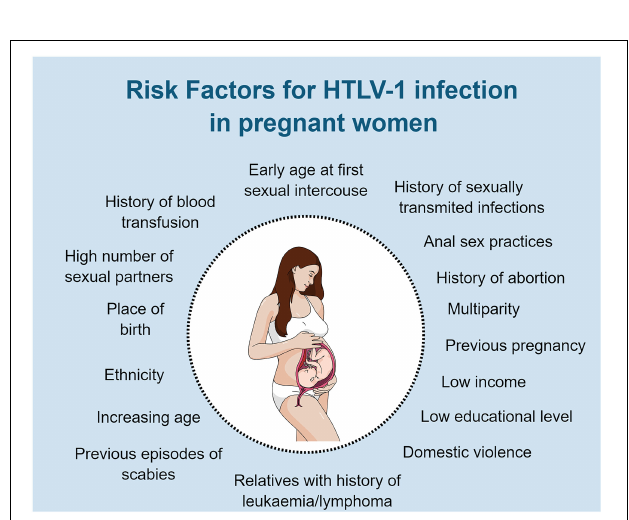
FIGURE 2 | Risk factors for HTLV-1 infection in pregnant women or women at reproductive age. Original figure created with